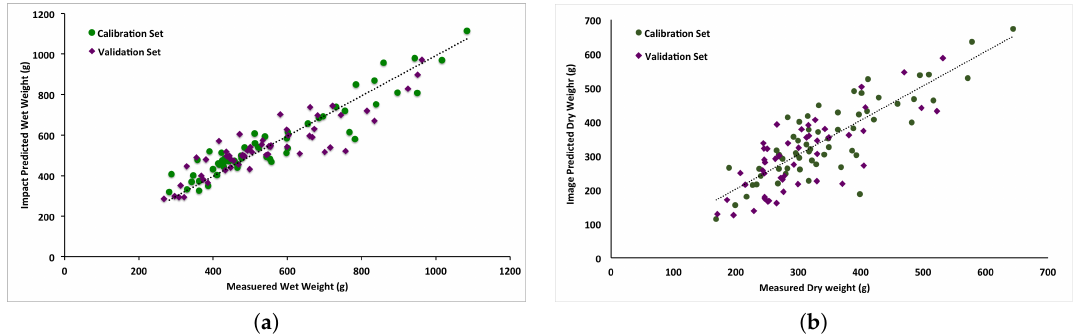
Figure 3. Linear regressions of the predicted total mass flow rate, M , using the impact mass flow estimation method ( a ) and dry matter flow rate, D , using the ECT method ( b ).